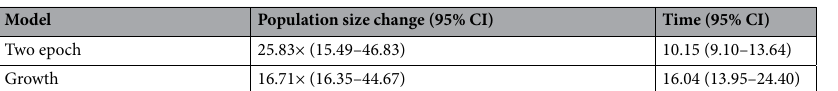
Table 5. The top-ranked demographic models and their optimized model parameter estimates. The 95% confidence intervals were obtained using non-parametric bootstrapping. The time values have been converted into thousands of years using the equation provided in the “Methods”